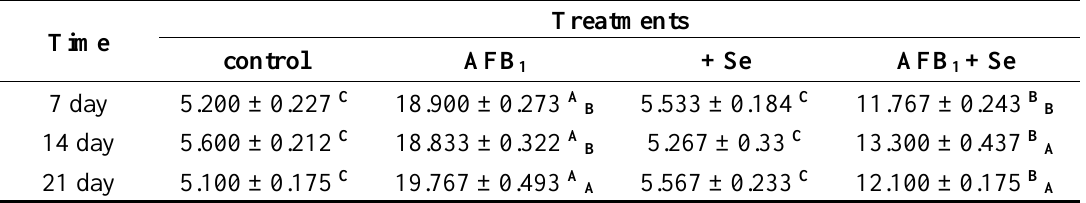
Table 3. The Number of TUNEL-positive Cells in the Apical Region of Jejunal Villi (number/0.064 mm 2